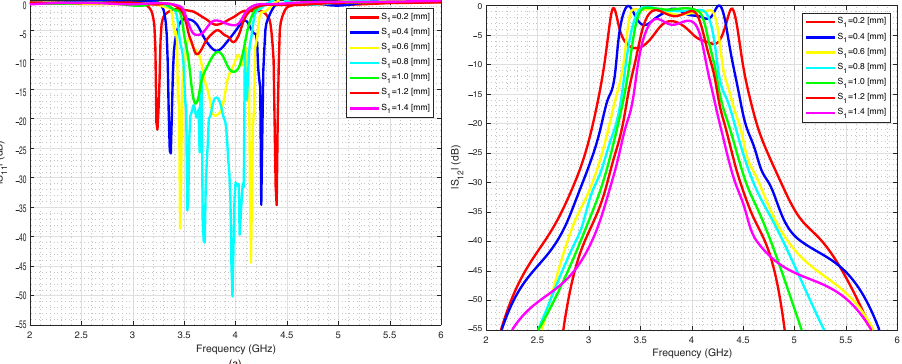
Figure 2. Pseudo hairpin filters scattering parameters versus S 1 geometrical parameter: ( a ) S 11 , ( b ) S 12 .